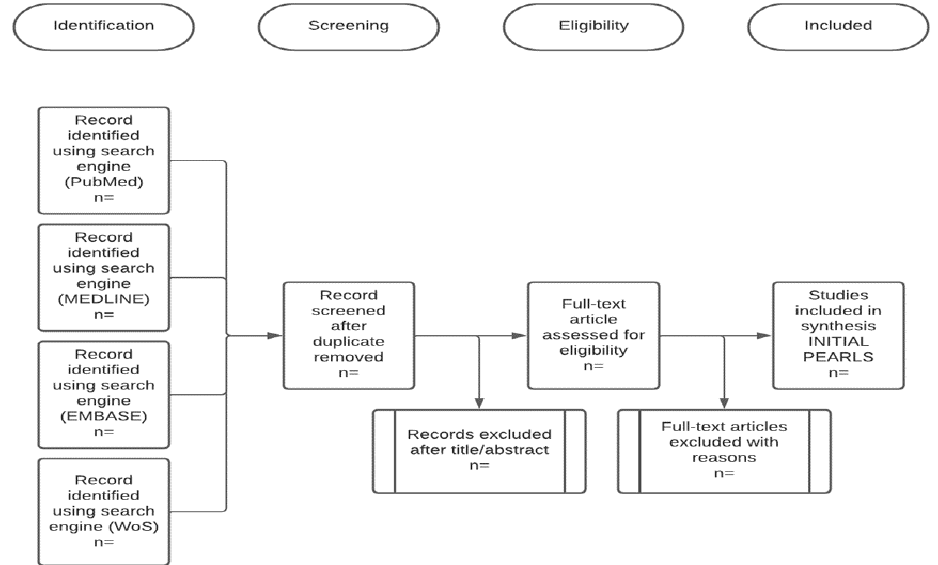
Figure 1. A schematic of the process of the systemic review. (Randomized controlled trials (R.C.T.s); Preferred Reporting Items for Systematic Reviews and Meta-Analyses (PRISMA).)